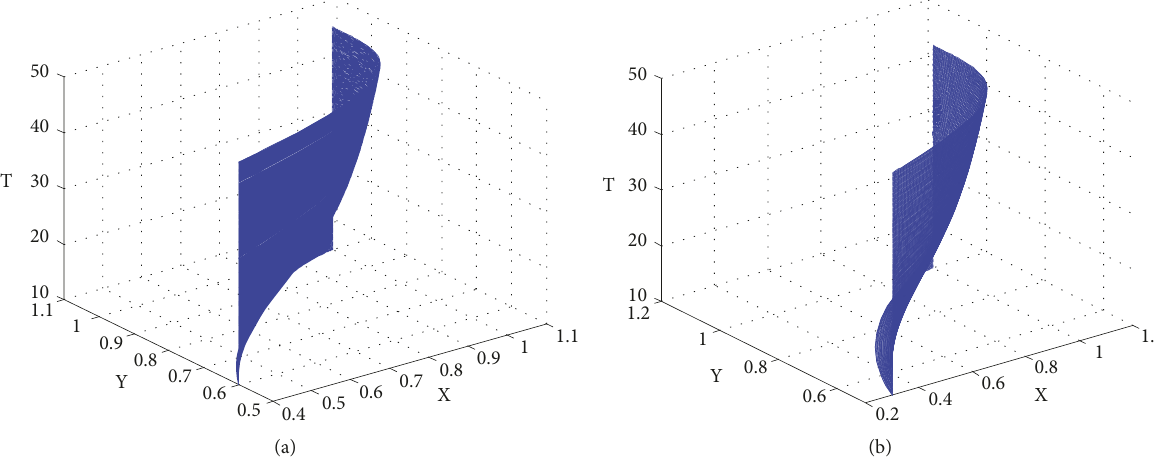
Figure 15: The change in 𝑇 with respect to the initial values of (0.4,0.6) and (0.3,0.5) in Scenario